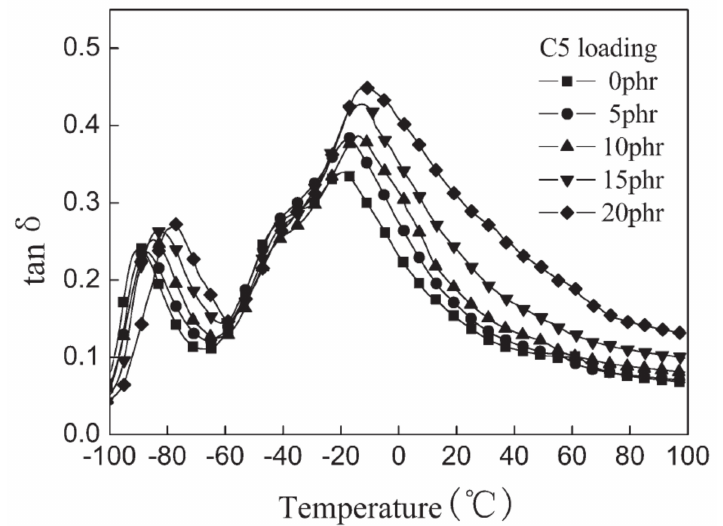
Figure 28. Temperature dependence of the damping loss factor (tan δ ) for BIIR/BR/C5 vulcanizates with different loading of C5 resin